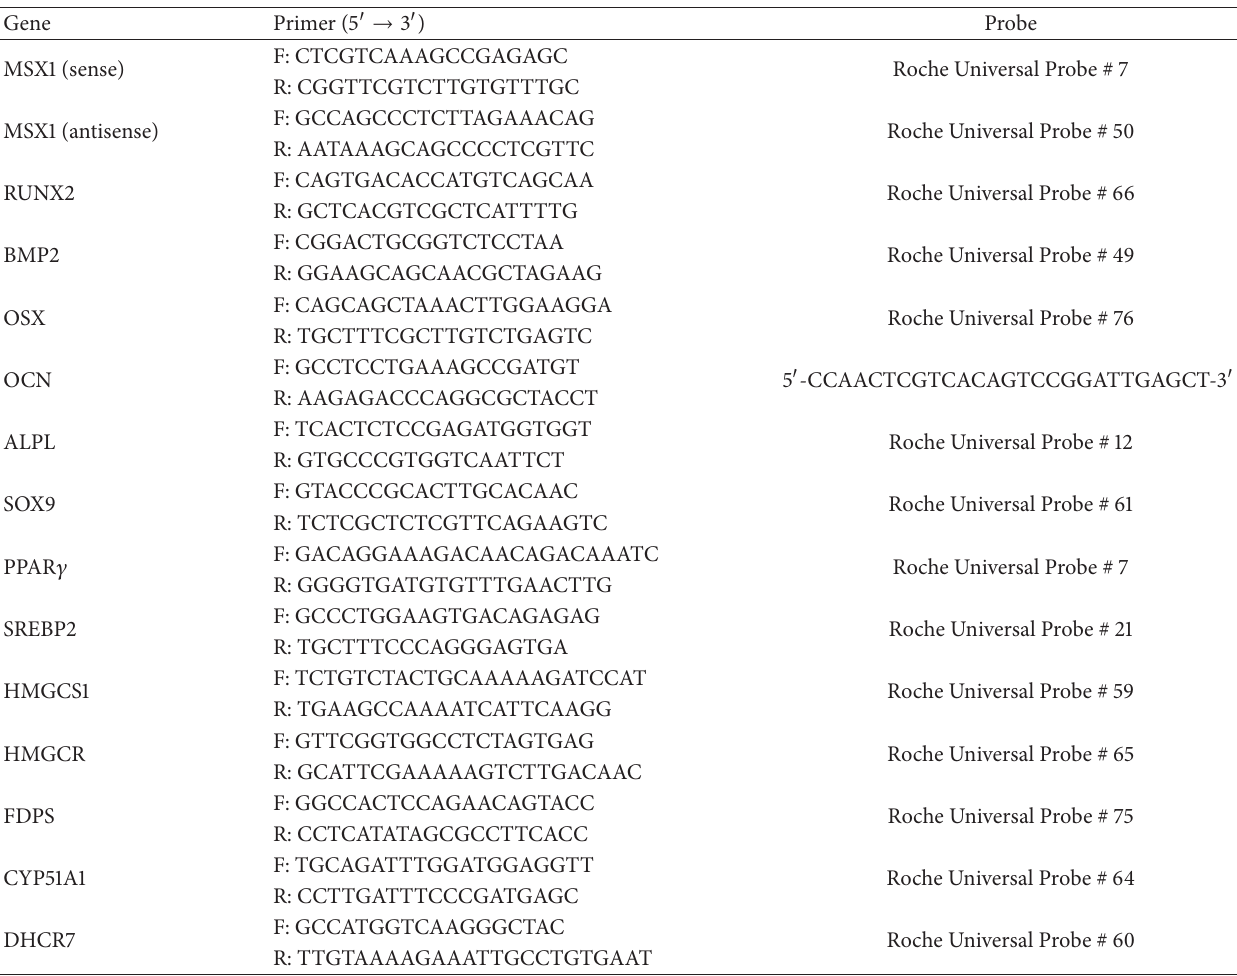
Table 1: Primer and probe sequences used for